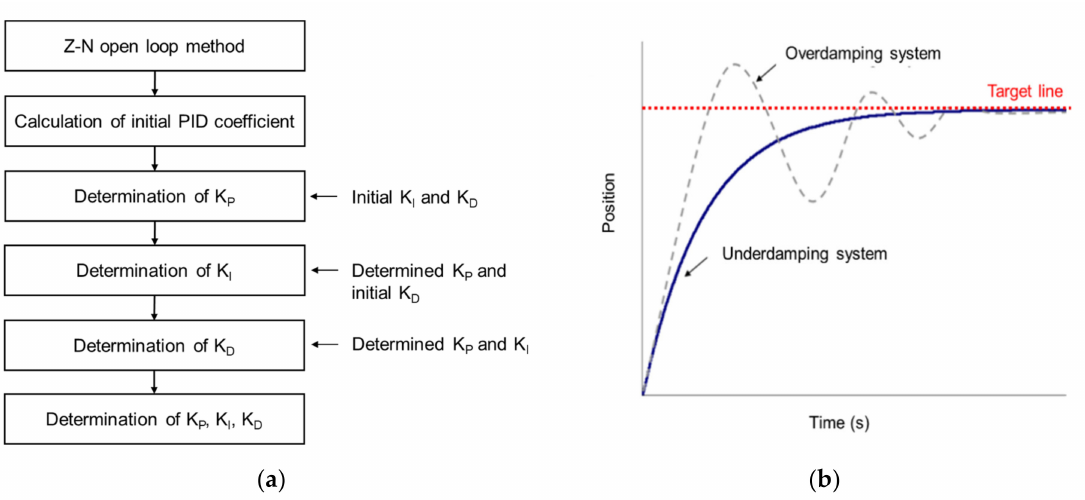
Figure 8. ( a ) Procedure for PID coe ffi cient determination; and ( b ) position control of clutch and shuttle shifting